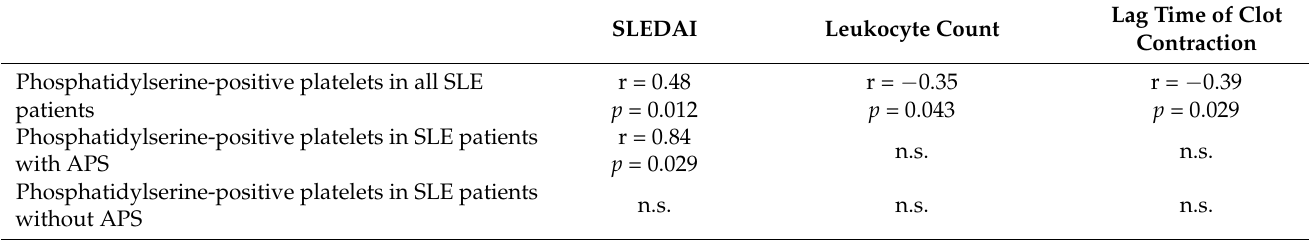
Table 2. Spearman’s correlation coefficients for the fractions of phosphatidylserine-expressing platelets ( a ), P-selectin-expressing platelets ( b ), and soluble P-selectin levels ( c ) versus the markers of immune inflammation and parameters of clot contraction in all the SLE patients studied and in two patient subgroups, i.e., patients with and without the antiphospholipid syndrome